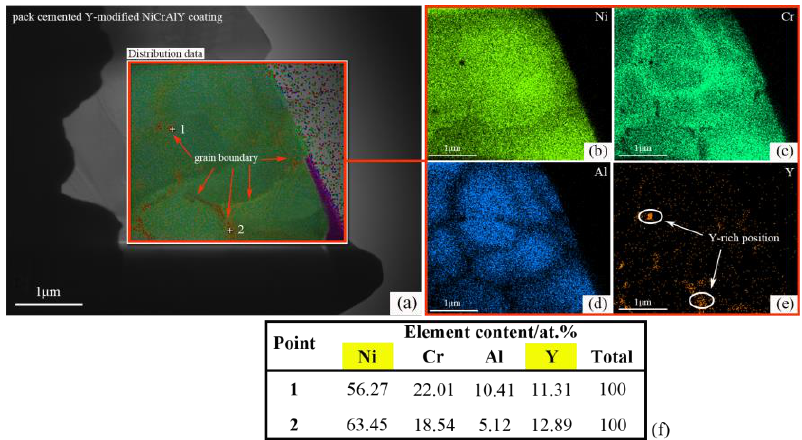
Figure 11. ( a ) S-TEM micrograph of pack-cemented Y-modified NiCrAlY coating, element distribution of ( b ) Ni; ( c ) Cr; ( d ) Al; ( e ) Y and ( f ) element contents in points 1 and 2.